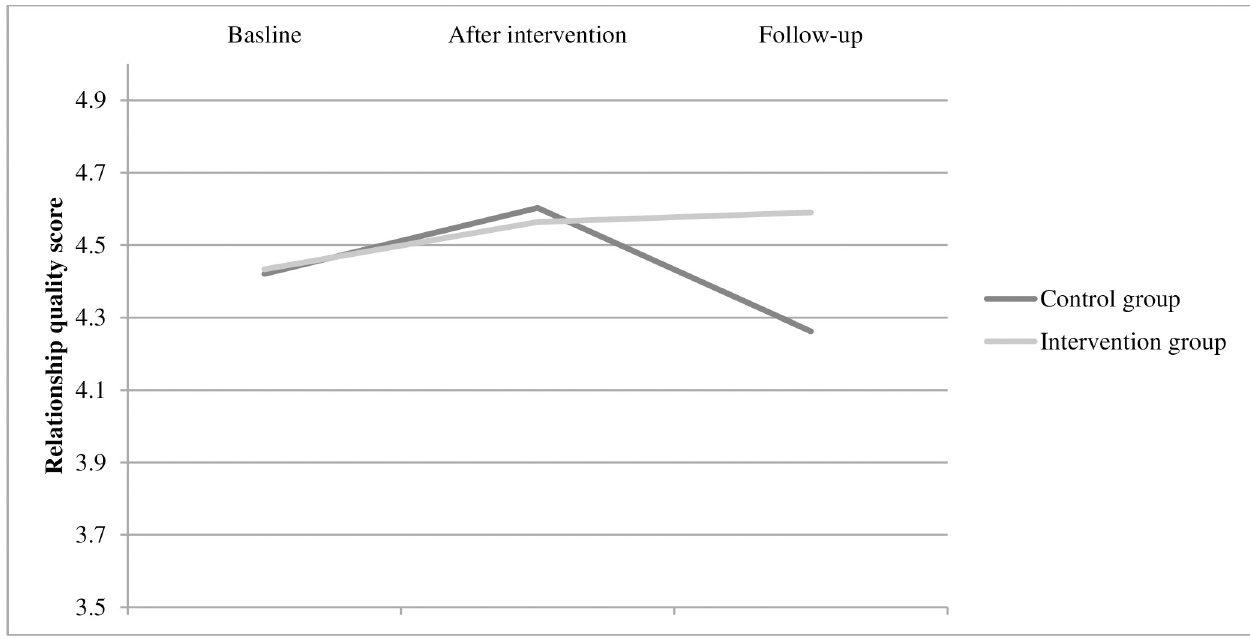
Fig 2. Mean scores for each group on relationship quality (CPRS) at each time point.